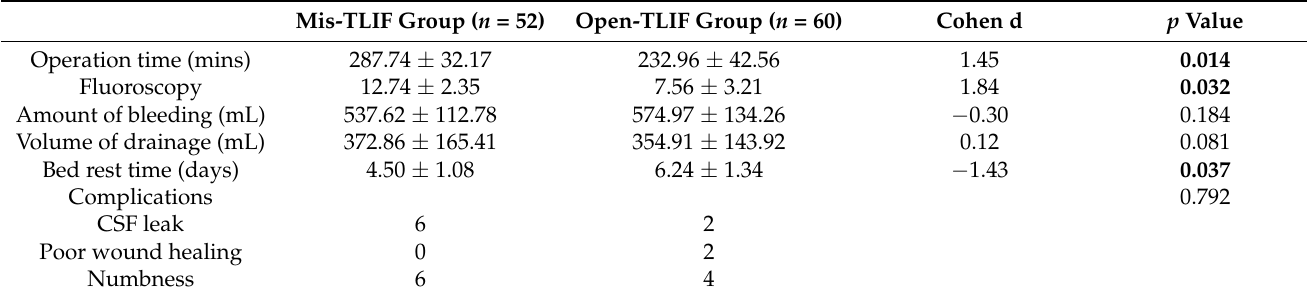
Table 2. Surgery-related indicators and complications of the two groups.